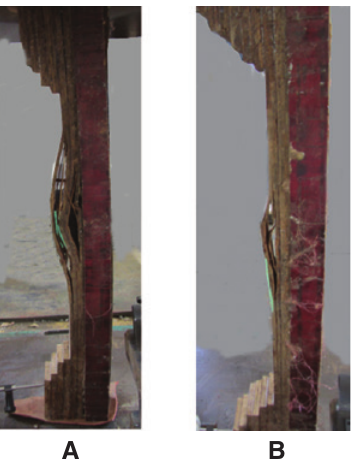
Figure 12: Buckling damage at the compressive side of the middle of the column. (A) ZP17 and (B)